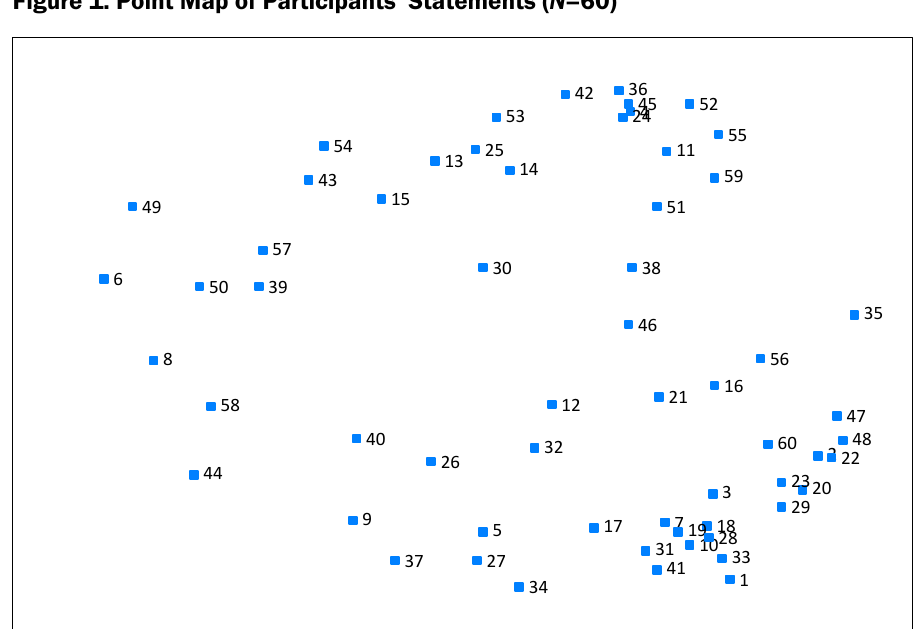
Figure 1. Point Map of Participants’ Statements ( N